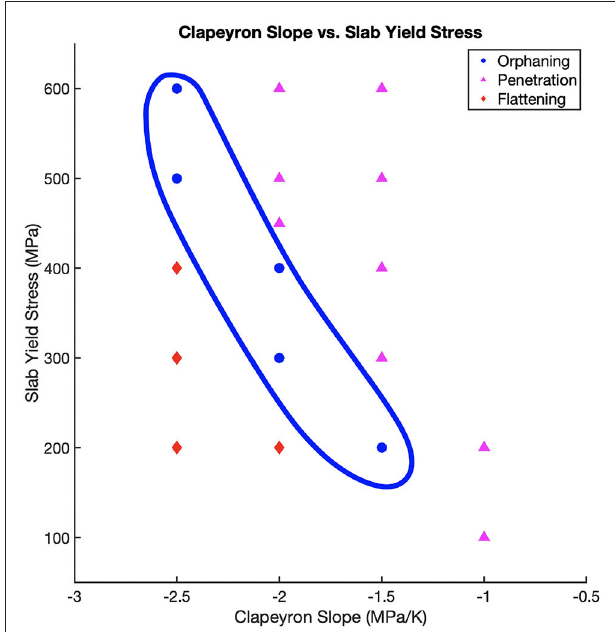
FIGURE 4 | Regime diagram for orphaning (blue circles), penetrating (magenta triangles), and deflected (red diamonds) slab morphologies in an ocean-ocean convergence setting. The orphaning regime space is highlighted in blue and shows that orphaning is prevalent for a range of slab yield stresses/slab strengths and Clapeyron slope values. Slab orphaning describes an intermediary space in the regime diagram between deflected and penetrating morphologies, indicating that orphaning as shown in Figure 9 , Videos S1 , S2 , can be one way for slabs to switch from one mode to the